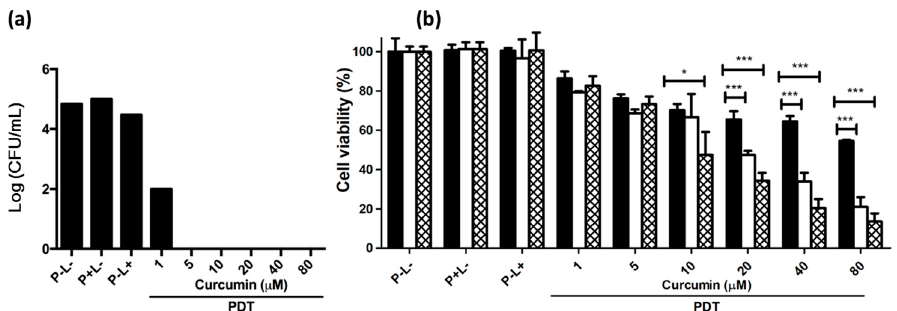
Figure 3. Viability of C. albicans in ( a ) planktonic culture and ( b ) adherent culture after PDT treatment. The total illumination time was 30 min. In the experiment of adherent C. albicans , illumination was carried out in one (filled), three (unfilled), or six (mesh) cycles. P and L represent photosensitizer and light, respectively. The symbol + indicates that the specific factor was used, and – indicates that the specific factor was not used. * p < 0.05, *** p < 0.001.